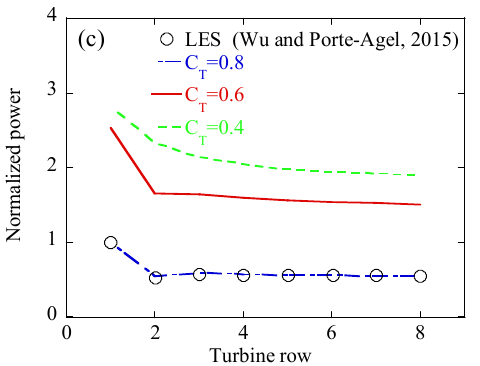
Figure 12. Effect of thrust coefficient on: ( a ) wind velocity; ( b ) turbulence intensity; ( c ) wind power generation of wind turbines in a row.